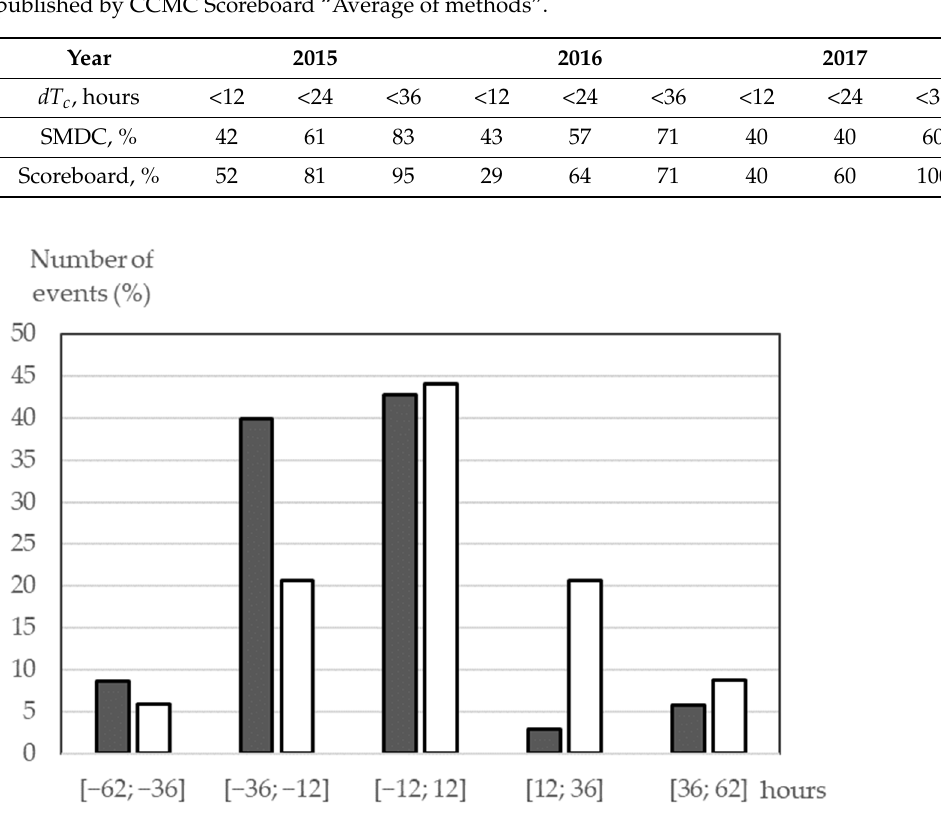
Figure 3. Distributions of the ICME arrival time errors for the events of 2015–2017 predicted by SMDC (the white bars) and CCMC Scoreboard (the gray bars). The y -axis shows the percentage of the observed hit events depending on the time error within the interval in hours marked on the x -axis. Table 3. Probabilities of the ICME forecast (in % of the observed hit events to all predictions) within the confidence intervals dT c of the arrival time for 2015–2017 obtained by the basic SMDC and pub- lished by CCMC Scoreboard “Average of methods”. Table 4. The probabilities of the ICME forecast (in % of the observed hit events to all predictions) within the confidence intervals dV c of the arrival speed for 2015–2017 for the basic